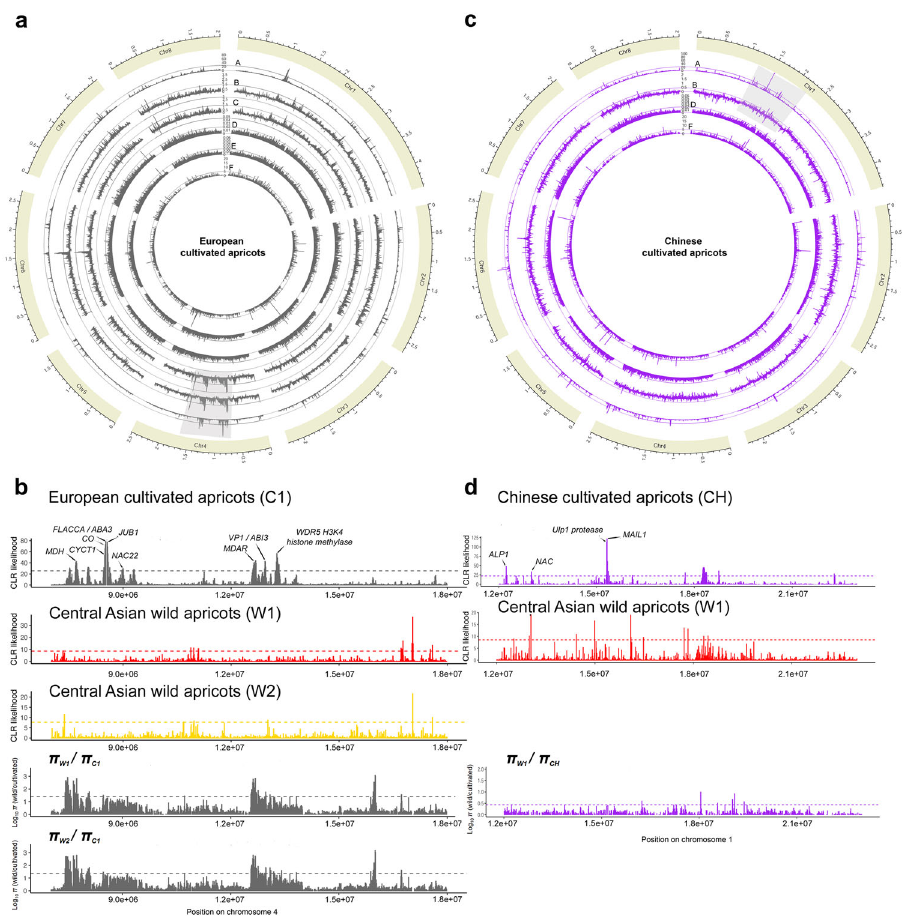
Fig. 6 Detection of positive selection in European and Chinese apricot genomes. Density of genes under positive selection along the European ( a ) and Chinese ( c ) cultivated apricot genomes. The different tracks are: A- Composite likelihood ratio (CLR) values, B- π W1 / π Cultivated ratio, C- π W2 / π Cultivated ratio, D- D XY pairwise values between W1 and cultivated apricots, E- D XY pairwise values between W2 and cultivated apricots; F- Linkage disequilibrium LD calculated with Omega. Shaded squares correspond to the intervals depicted in close-up in ( b ) and ( d ). Broken lines indicate the Top 0.5% threshold. Arrows indicate target genes for selection as discussed in the manuscript. W1 in red and W2 in yellow: wild Southern and Northern Central Asian P. Armeniaca , C1 in grey and CH in purple: European and Chinese cultivated P. armeniaca , respectively. Source data are provided as a Source Data fi